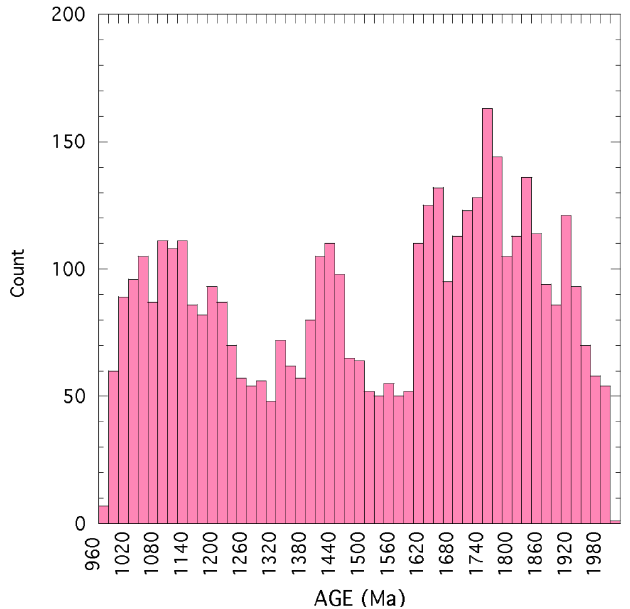
Figure 18. Distribution of detrital zircon ages in Laurentia. Data from Belousova et al. [5] and Condie et al. [13] and references